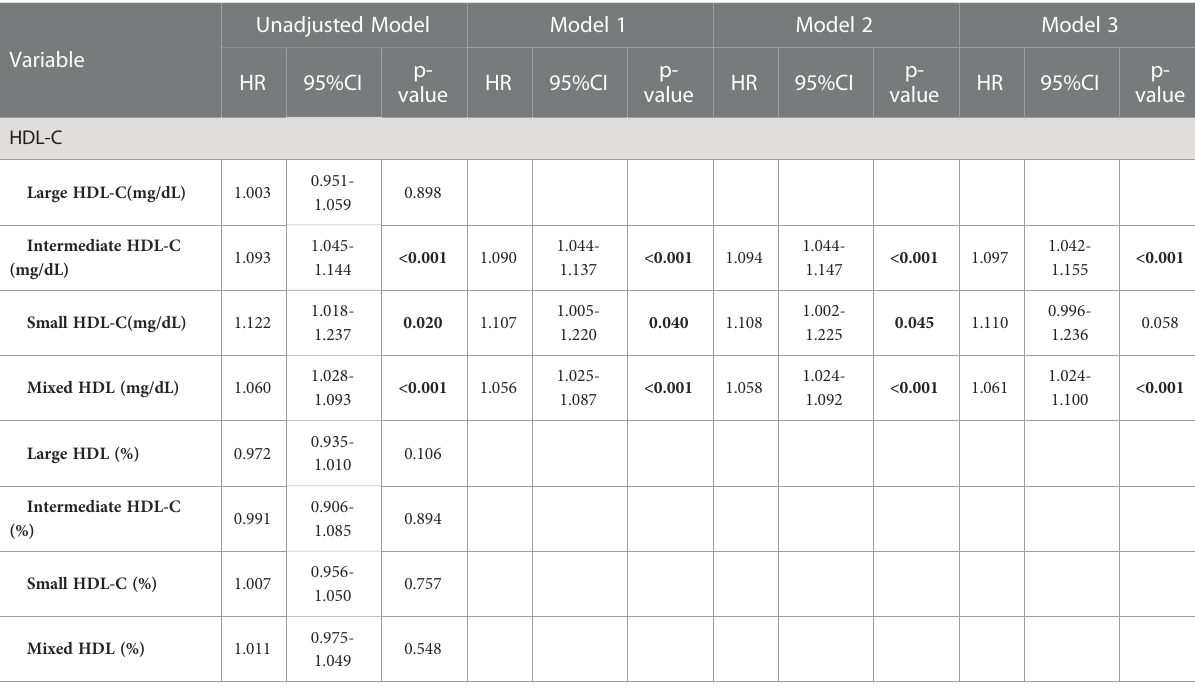
SCAD, stable coronary artery disease; T2DM, type 2 diabetes mellitus. p < 0.05 suggests signi fi cant